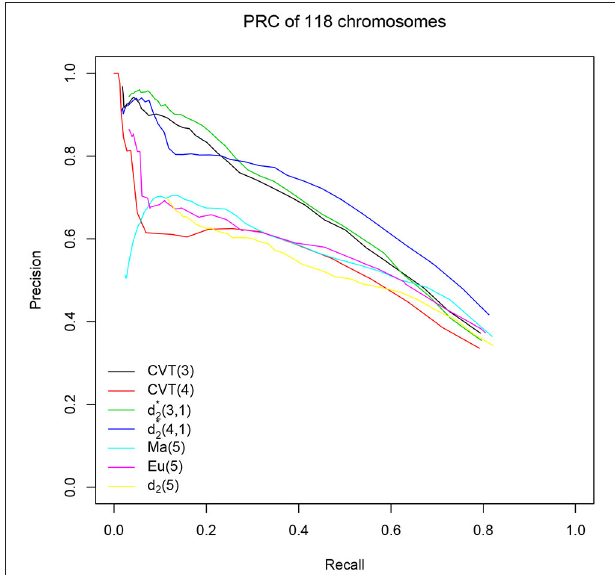
FIGURE 3 | The Precision-Recall Curves (PRC) of the different methods based on 118 genomes with known HGT genomic islands.